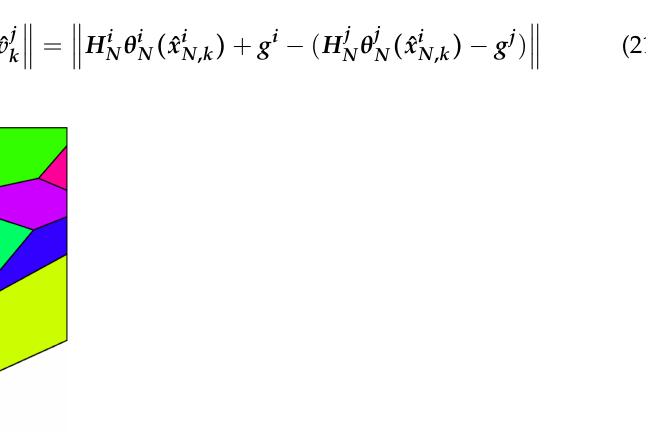
Figure 3. Illustration of detecting a critical region